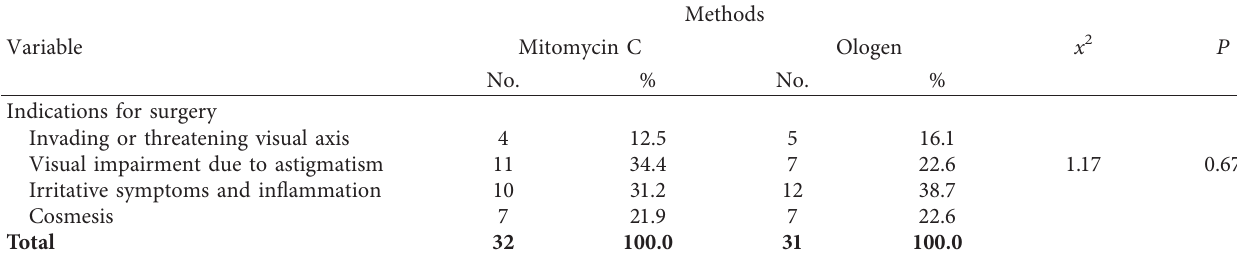
Table 3: Distribution of patients in both groups regarding the indications of surgery.